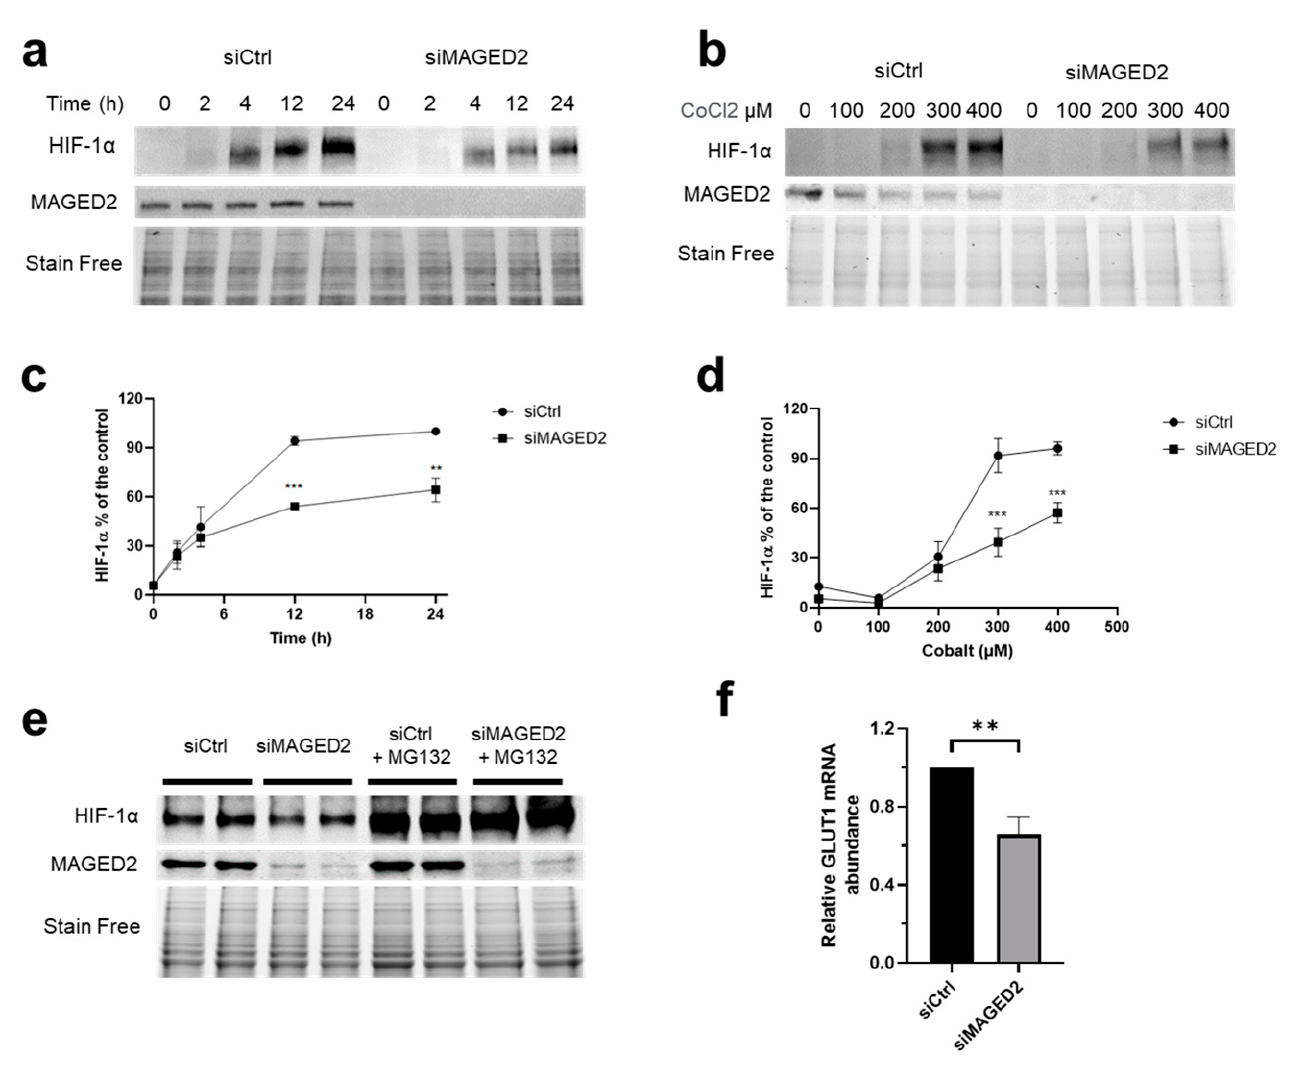
Figure 1. MAGED2 promotes hypoxic HIF-1 α protein expression in HeLa cells. HeLa cells were transfected with control (siCtrl), MAGED2 (siMAGED2). Briefly, 24–48 h post-transfection, cells